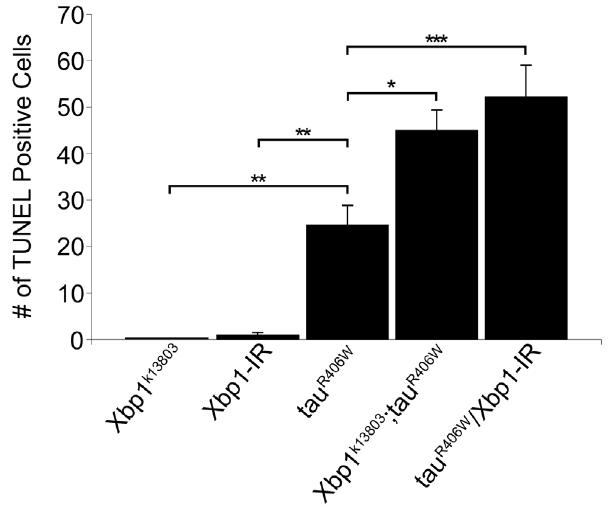
Figure 3. Quantitative analysis of cell death using TUNEL staining. A significant increase in toxicity in flies with reduced levels of Xbp1 using a loss of function allele ( Xbp1 k13803 / + ) or by expressing RNAi to Xpb1 (Xbp1-IR) with the panneural elav-GAL4 driver. *P , 0.05, **P , 0.01, *** P , 0.001, one-way ANOVA with Tukey test for multiple comparisons. Flies are 10 days old.